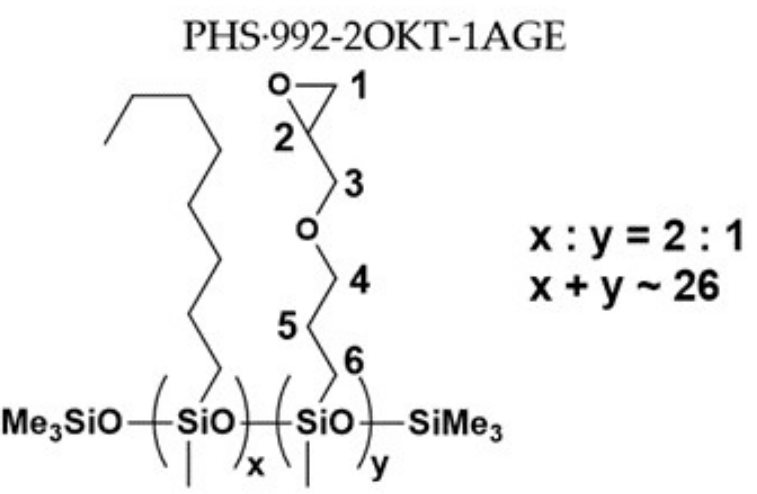
Scheme 3. The scheme of the structure of the MFSC 3